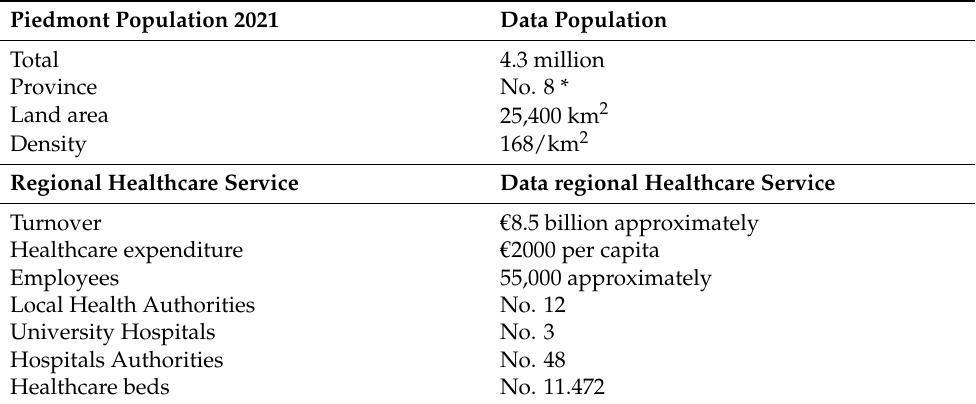
Table 3. Main information on Population, and Piedmont Health Service.